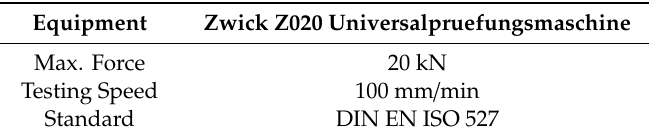
Table 4. Tensile test characteristics.